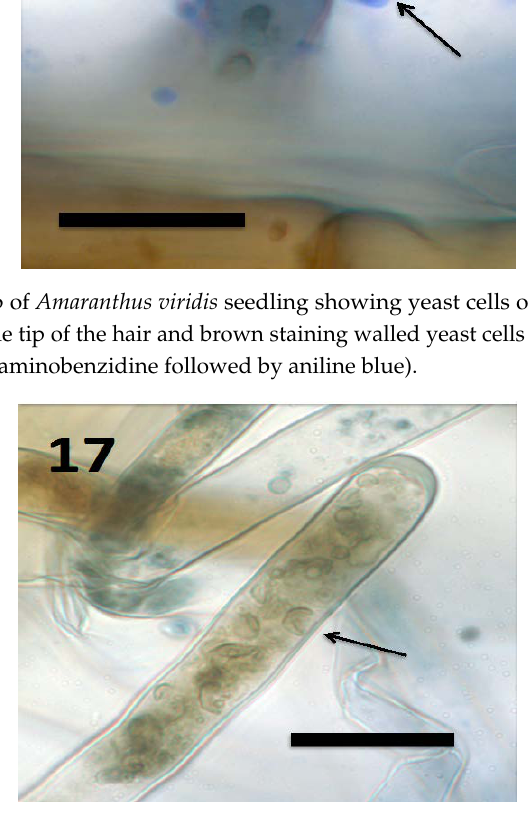
Figure 17. Root hair of Froelichia gracilis seedling showing internal yeast cells (collapsed mycosomes) of Aureobasidium pullulans (arrow; bar = 15 µm; stained with 3,3-diaminobenzidine followed by aniline blue).